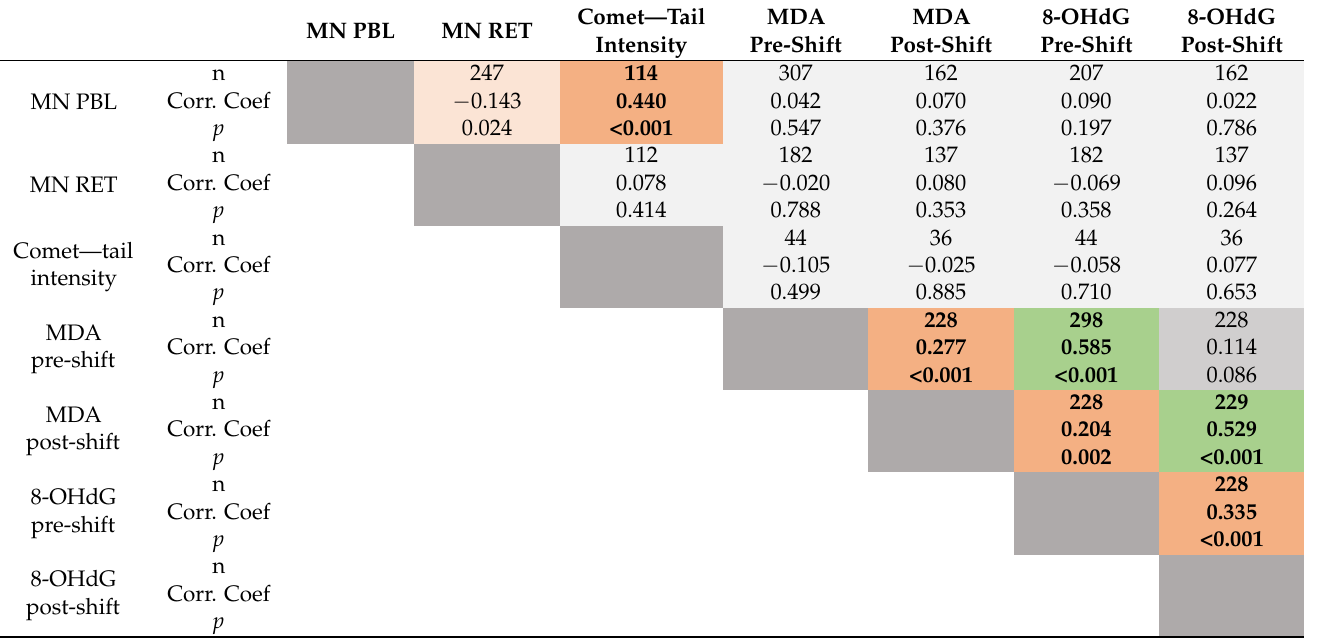
Table 3. Correlation between the effect biomarkers considering the data from all the